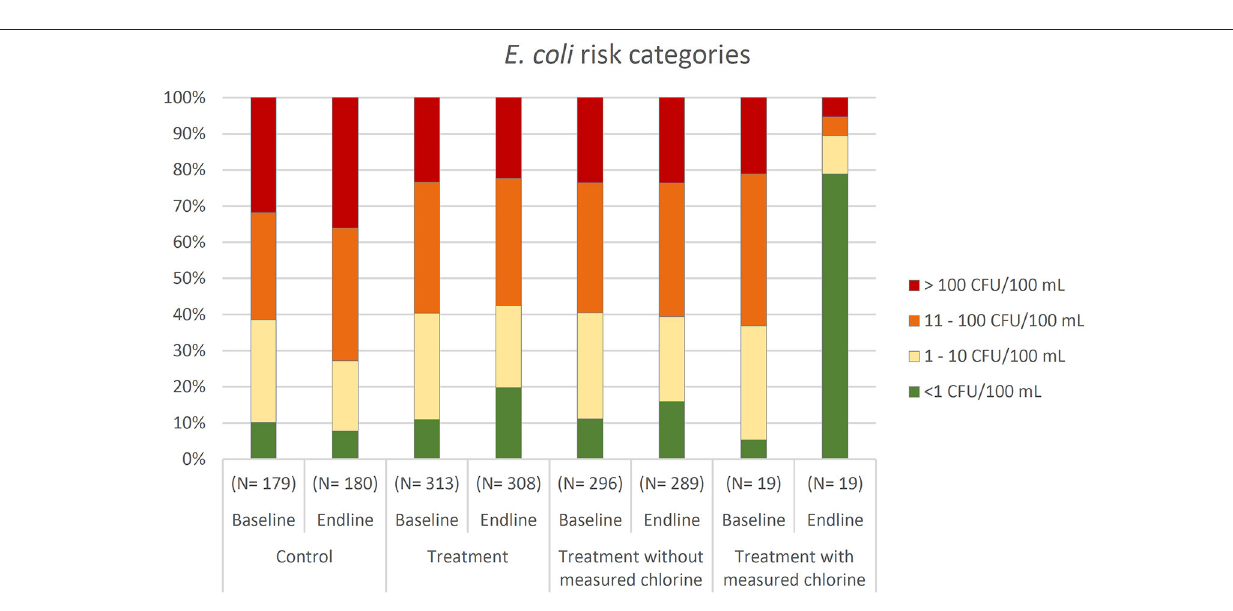
FIGURE 4 | Percentage of households within the different E. coli risk categories of low risk ( < 1 CFU/100mL), intermediate risk (1–10 CFU/100mL), high risk (11–100 CFU/100mL), and very high risk ( > 100 CFU/100mL) at baseline and endline in the control and treatment systems, including treatment systems with and without detectable chlorine at